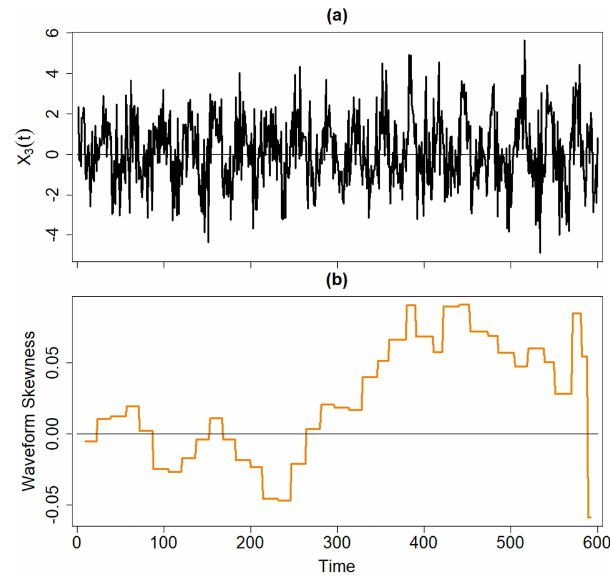
Figure 3. (a) The time series X 3 (t) and (b) its waveform skewness time series associated with the point (32, 32) in the waveform spec- trum.